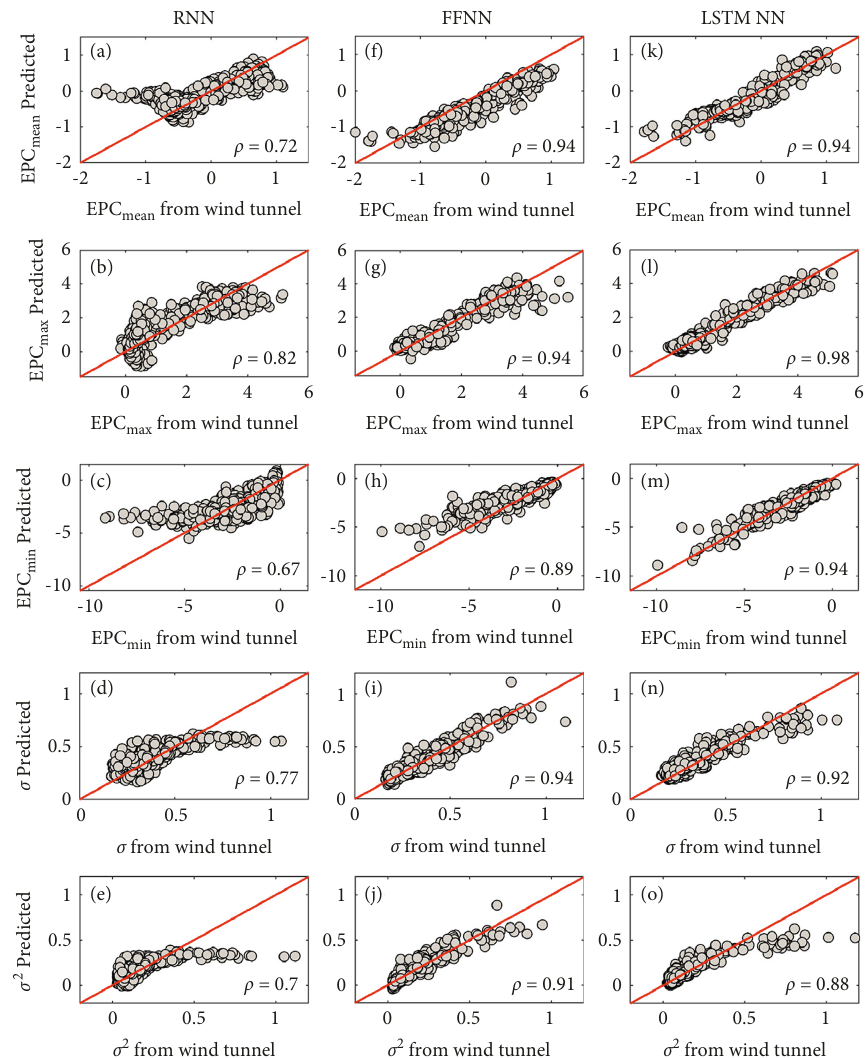
Figure 9: Comparison of the EPC 2 values predicted by the trained ANN models and the second validation set mean , EPC max , EPC min , σ , and σ and those obtained from wind tunnel tests: (a), (b), (c), (d), (e) RNN; (f), (g), (h), (i), (j) FFNN; (k), (l), (m), (n), (o) LSTM NN. The red line indicates the ideal